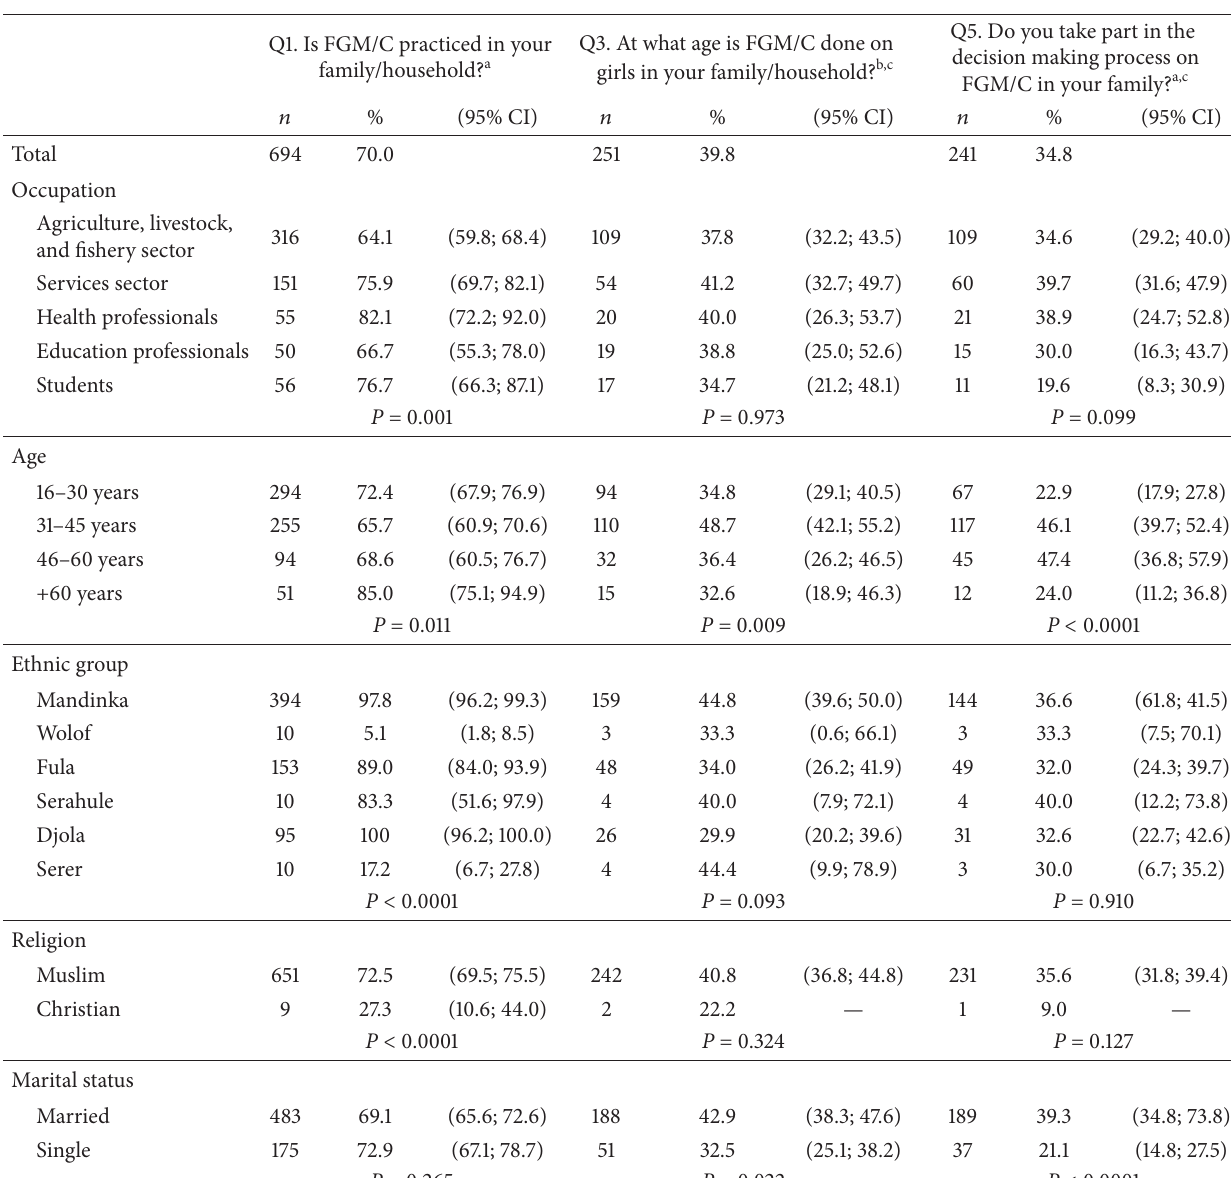
Table 3: Knowledge, attitudes, and practices according to socio-demographic